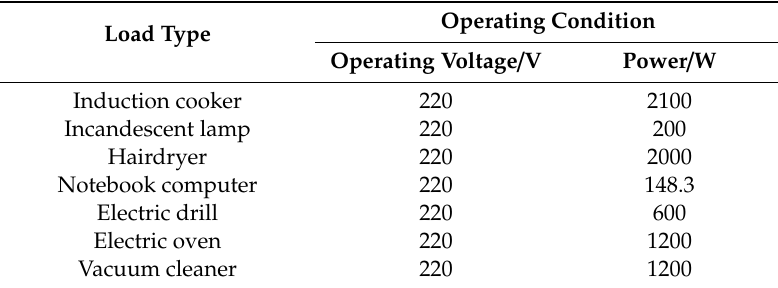
Table 1. The operation conditions of the di ff erent loads.